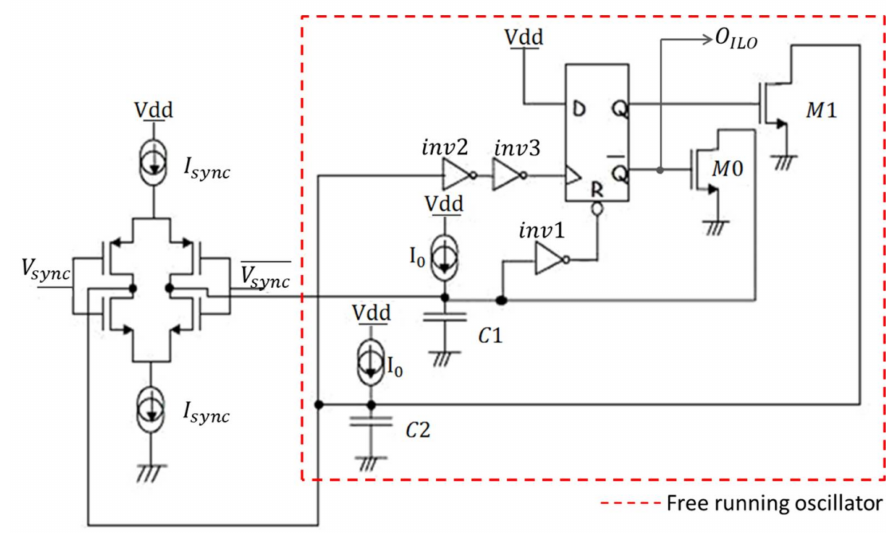
Figure 4. Schematic of the Injection Relaxation Locked